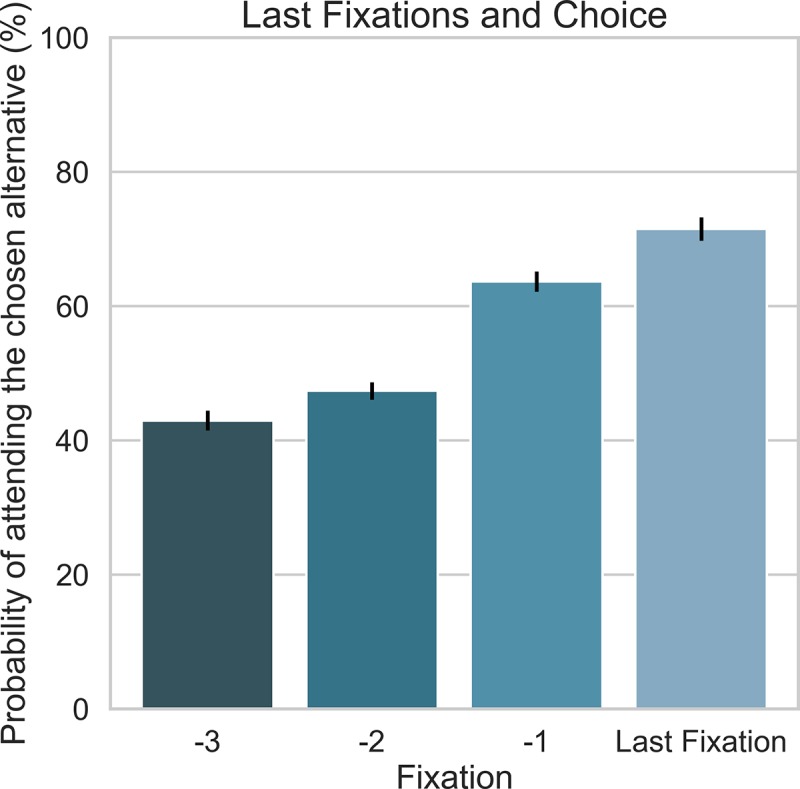
The probability of fixating on an attribute of the chosen alternative as a function of the last four fixations.Error bars correspond to standard errors of the mean.